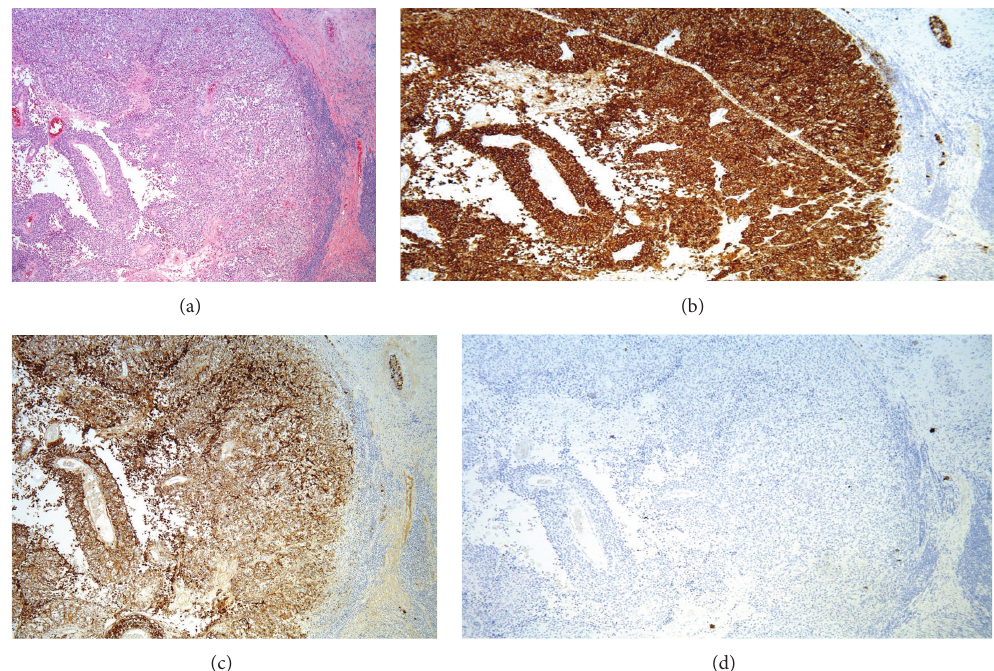
Figure 2: (a) Metastatic melanoma replacing a lymph node with a thin rim of residual lymphocytes (far right) H&E 5x. (b) The malignant cells are strongly positive for Melan A, (c) positive for HMB45, and (d) negative for cytokeratin AE1/AE3 (IHC, 5x). Although this staining pattern could be seen in benign and malignant melanocytes, its presence in a lymph node indicates